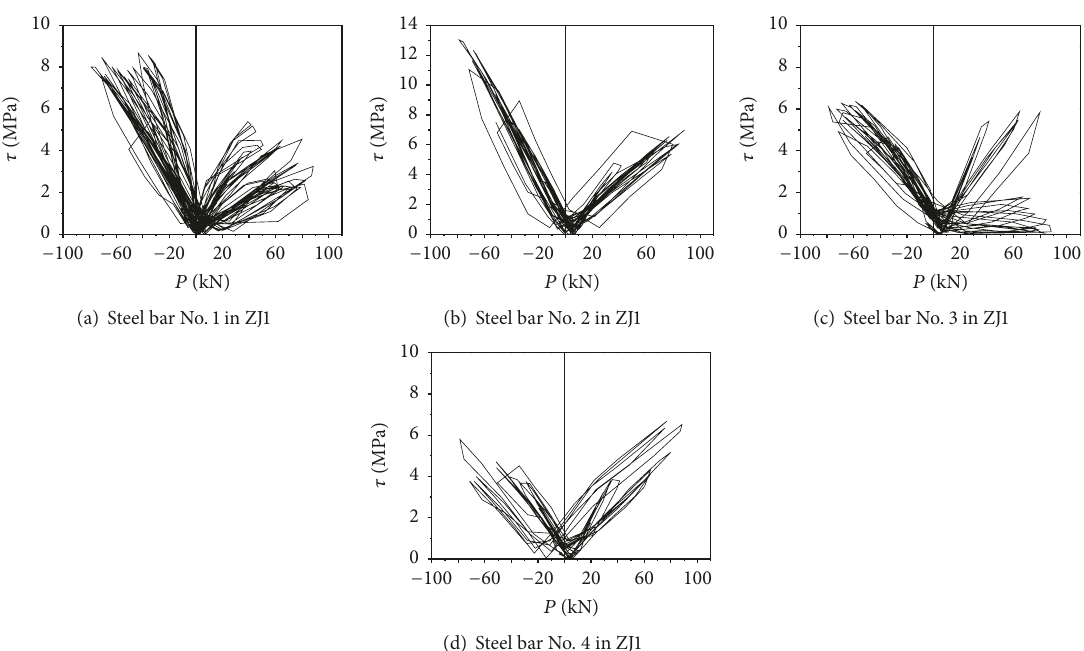
Figure 10: Load-bond stress hysteresis curve of tested longitudinal steel bars in ZJ1 specimen.